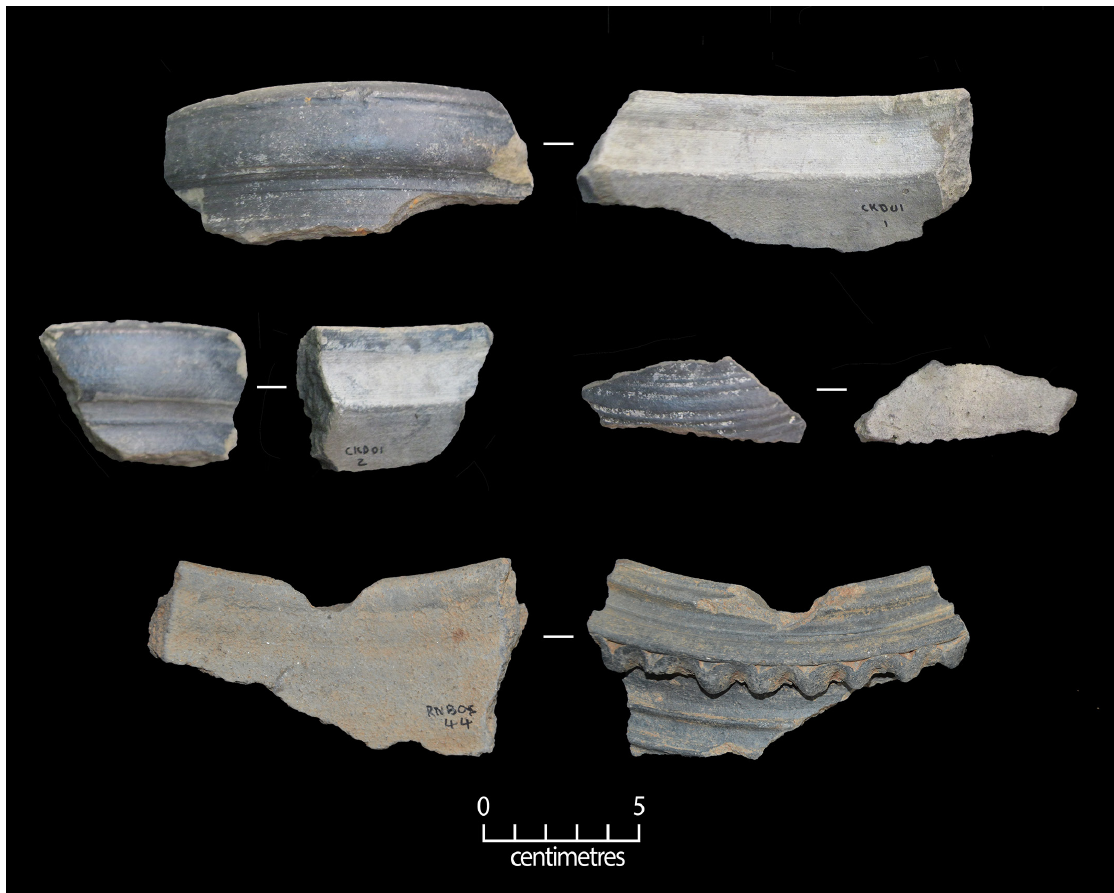
Figure 15: External and internal surfaces of various Class 5 variant 1 potsherds.